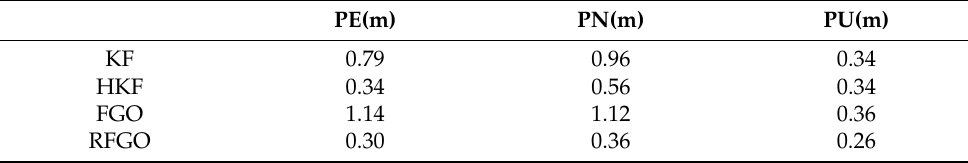
Table 1. Comparison of the positioning error in the